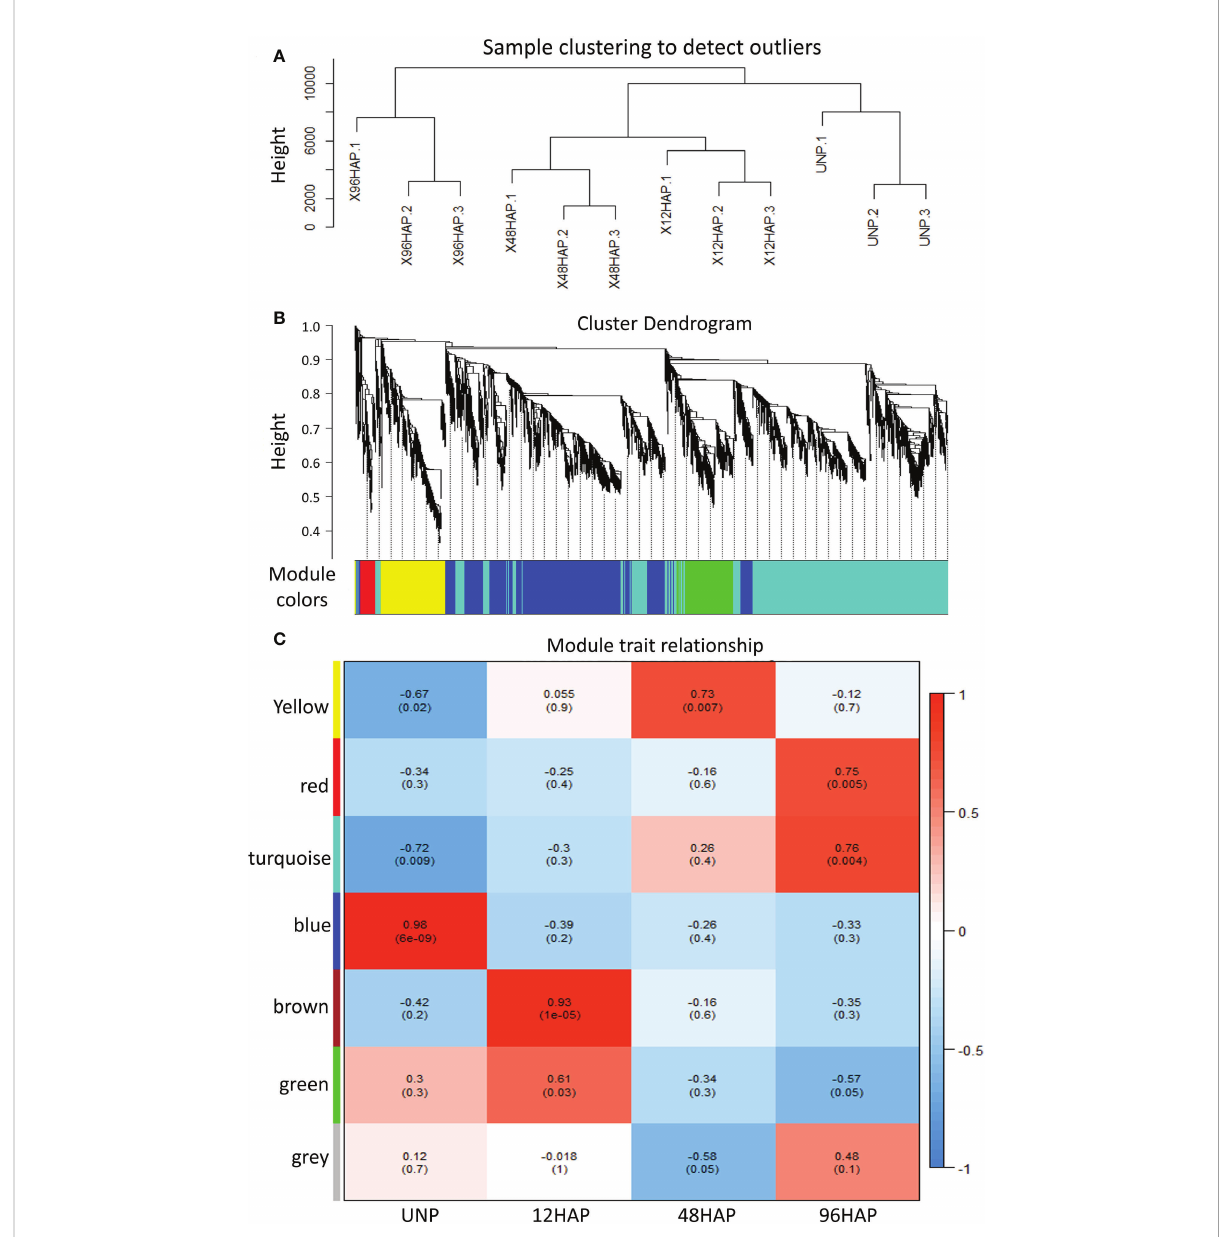
FIGURE 4 WGCNA analysis for expressed genes at sepal development time points after pollination (12, 48, 96 HAP) in comparison with un-pollinated sepals (UNP). (A) Sample clustering to detect outliers for DEGs. (B) Dendrogram clusters seven modules for DEGs. (C) Module trait relationship. DEGs mainly enriched in turquoise and green